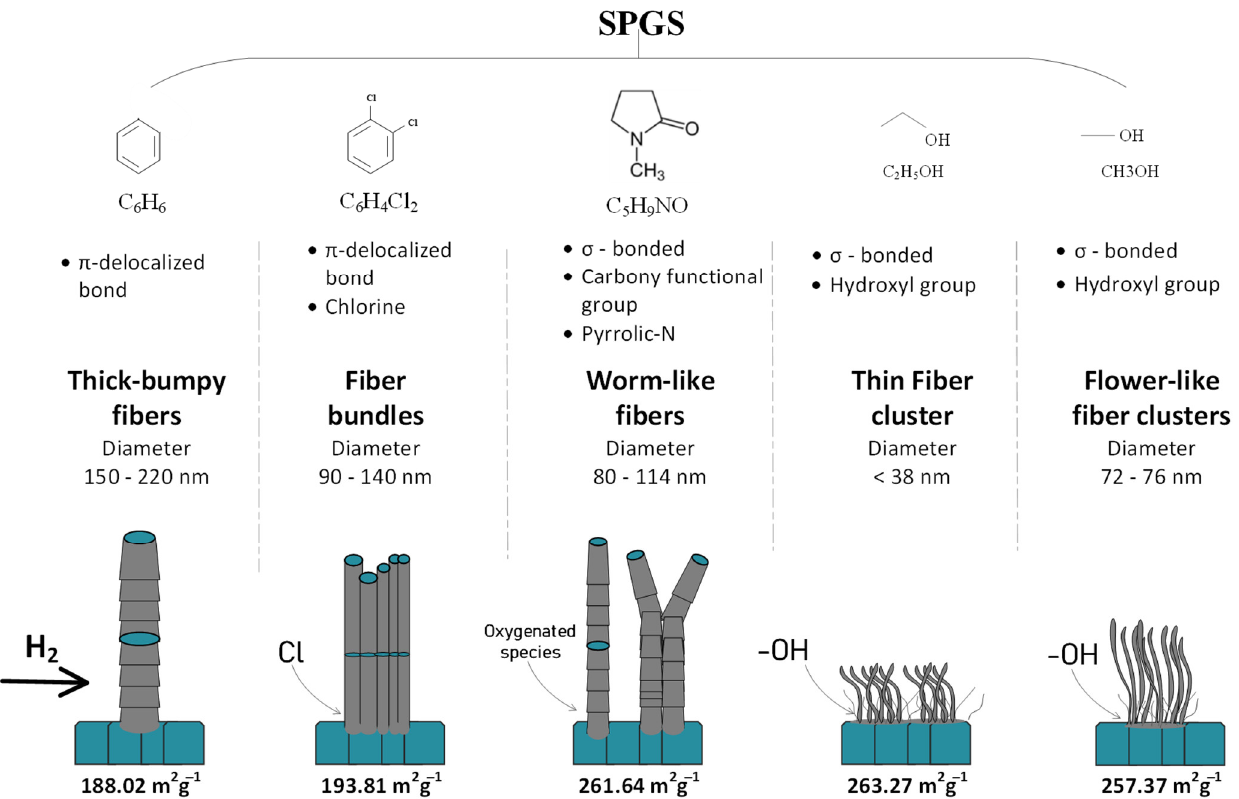
Figure 7. Precursor affecting the morphology of fibers.